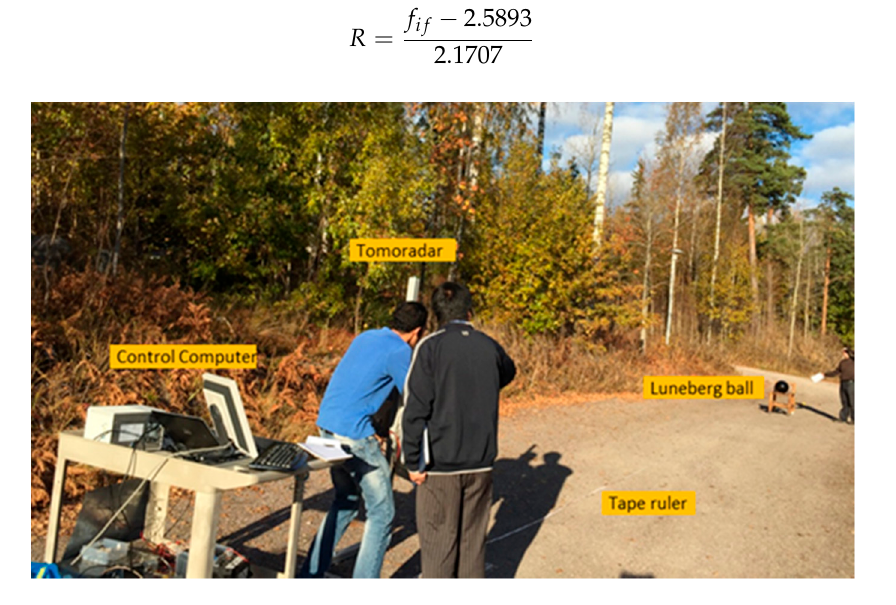
Figure 3 . Range calibration. Figure 3. Range calibration. Remote Sens. 2017 , 9 , 58